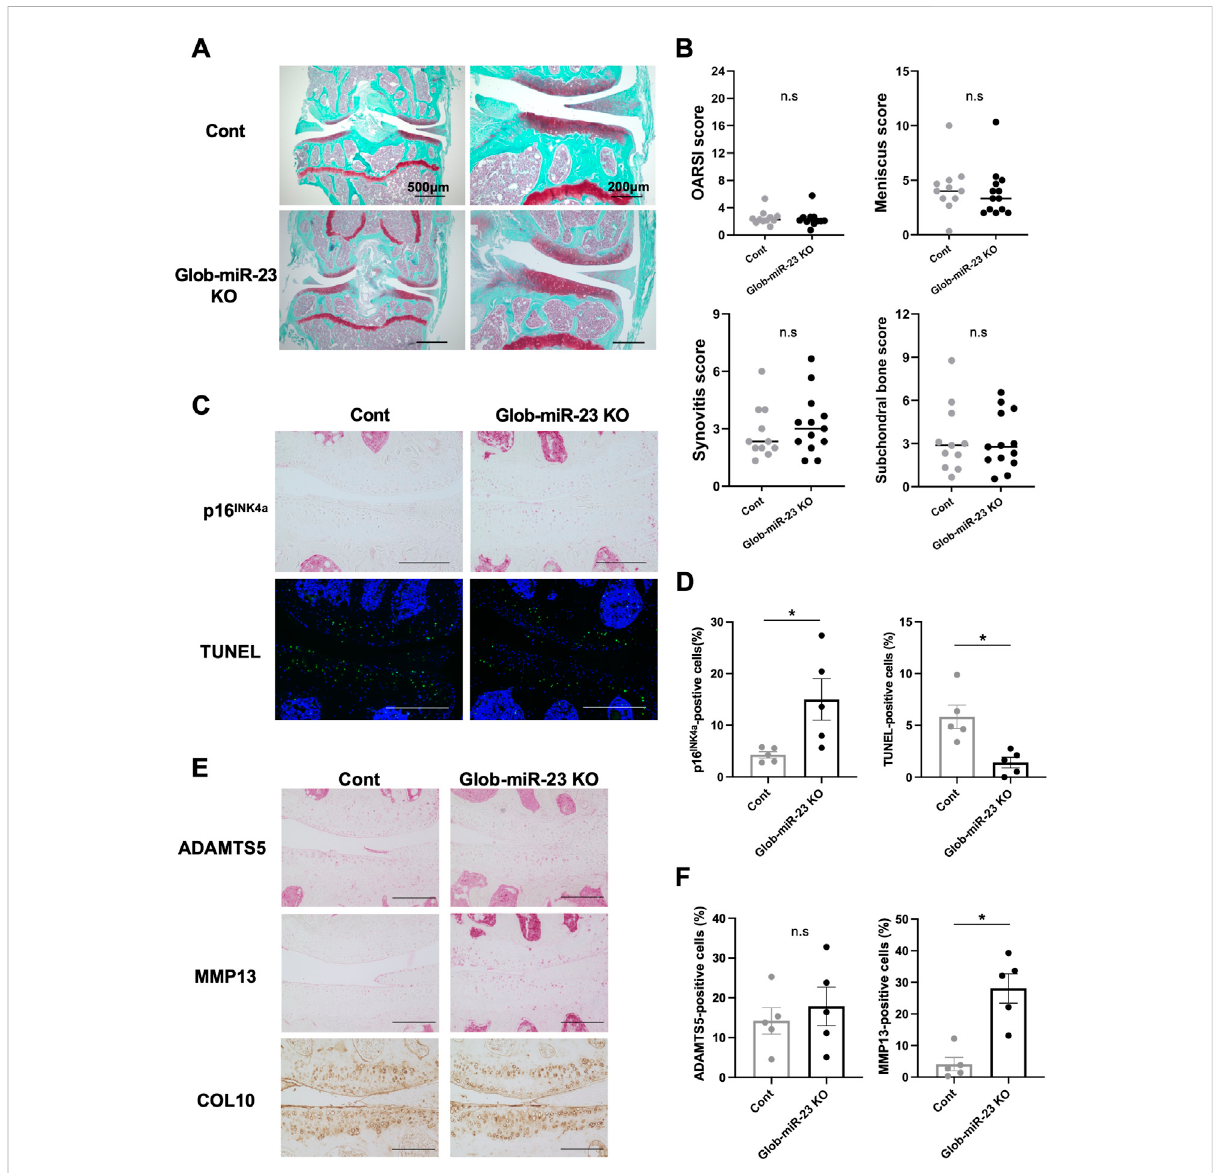
FIGURE 7 Histopathological evaluation of Knee joint tissues in Glob-miR-23clus KO mice with aging. (A) Safranin O staining of the knee joints of Control and Glob-miR-23clus KO mice at 12 months of age. Scale bars: 500 µm and 200 µm. (B) The right knee joints of Control and Glob-miR-23clus KO miceat12 µmmonthsofage(Control: n =11,Glob-miR-23clusKO: n =13)wereassessedbyOARSIscoring,meniscusscoring,synovitisscoringand ScB scoring system. The data was represented as median. Comparison of scoring data was performed by Mann-Whitney U test. (C,D) Knee joints from Control and Glob-miR-23clus KO mice were assessed by immunohistochemistry using anti-16 INK4a antibodies, and TUNEL staining ( n = 5pergroup).Scalebars:200 µm. (E,F) Immunohistochemistry(ADAMTS5,MMP13,andtypeXCollagen)inarticularcartilageofkneejointsinControl and Glob-miR-23clus KO mice ( n = 5 per group). Scale bars: 200 µm. All data was represented as mean ± SEM. Comparison of mean values was performed by Welch ’ s t -test; * p < .05. n. s: non-signi fi cant